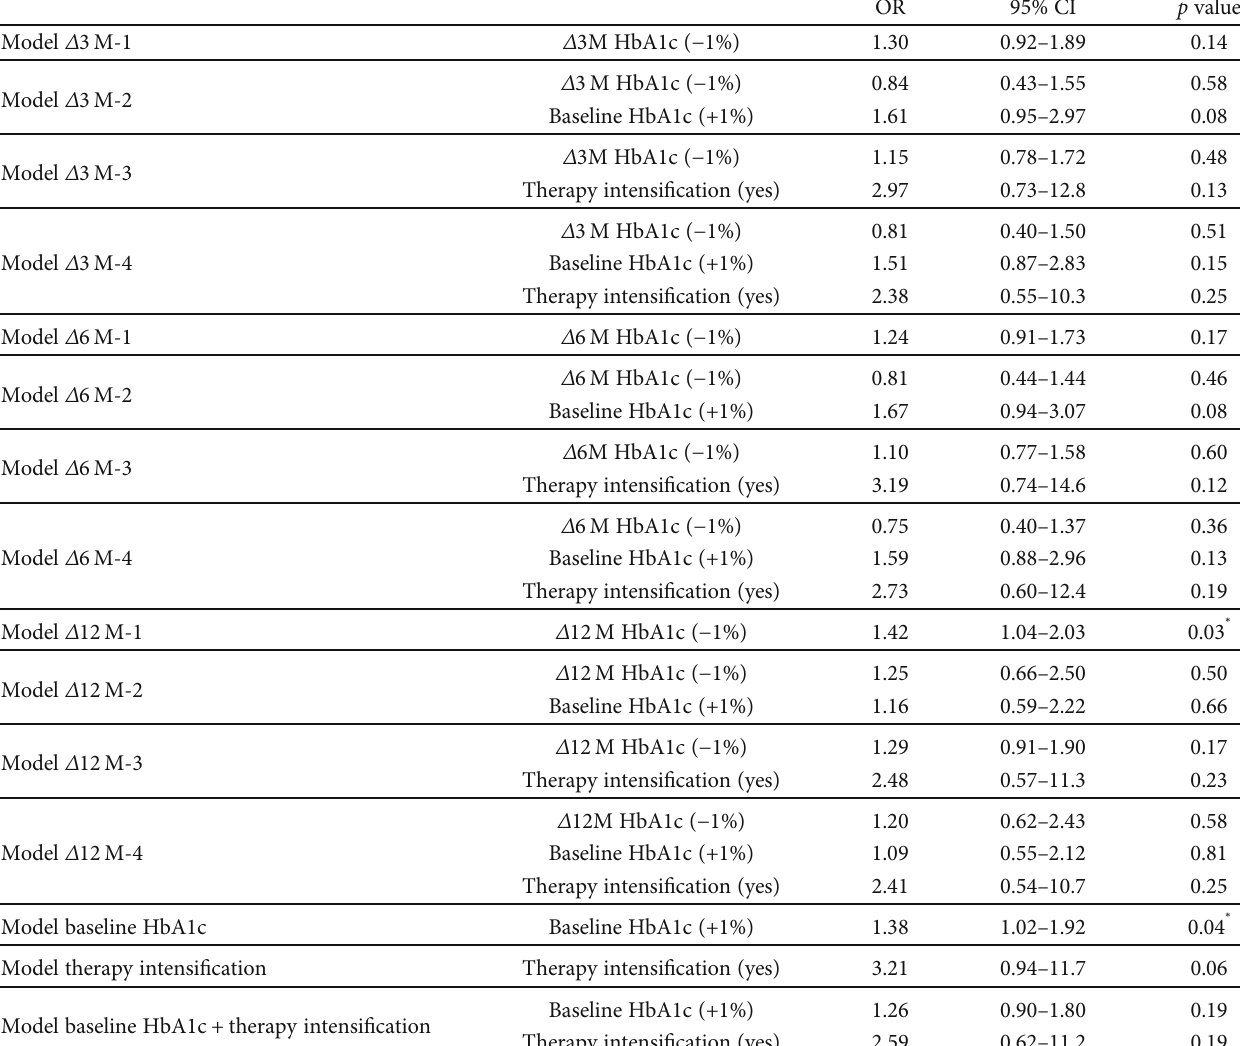
Table 3: Multivariate logistic regression analysis of possible factors for retinopathy progression in patients with simple diabetic retinopathy.